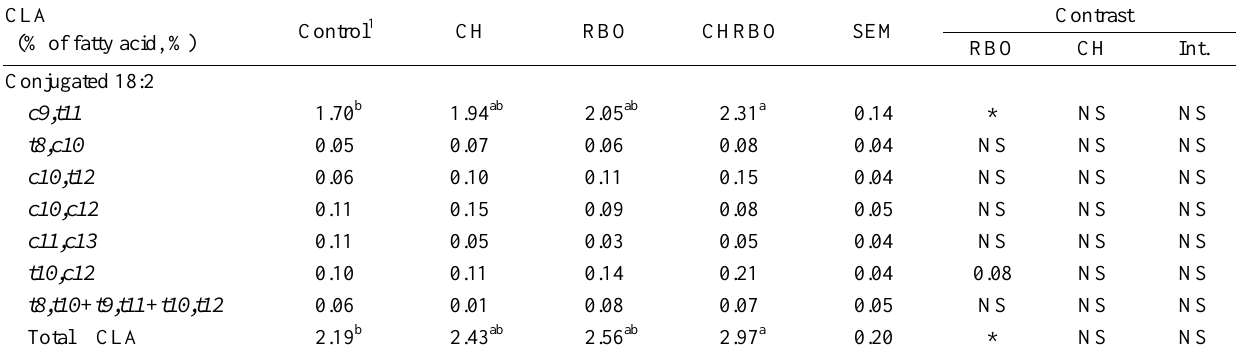
Table 8. Effect of cassava hay and rice bran oil on conjugated linoleic acid (CLA) in milk fat